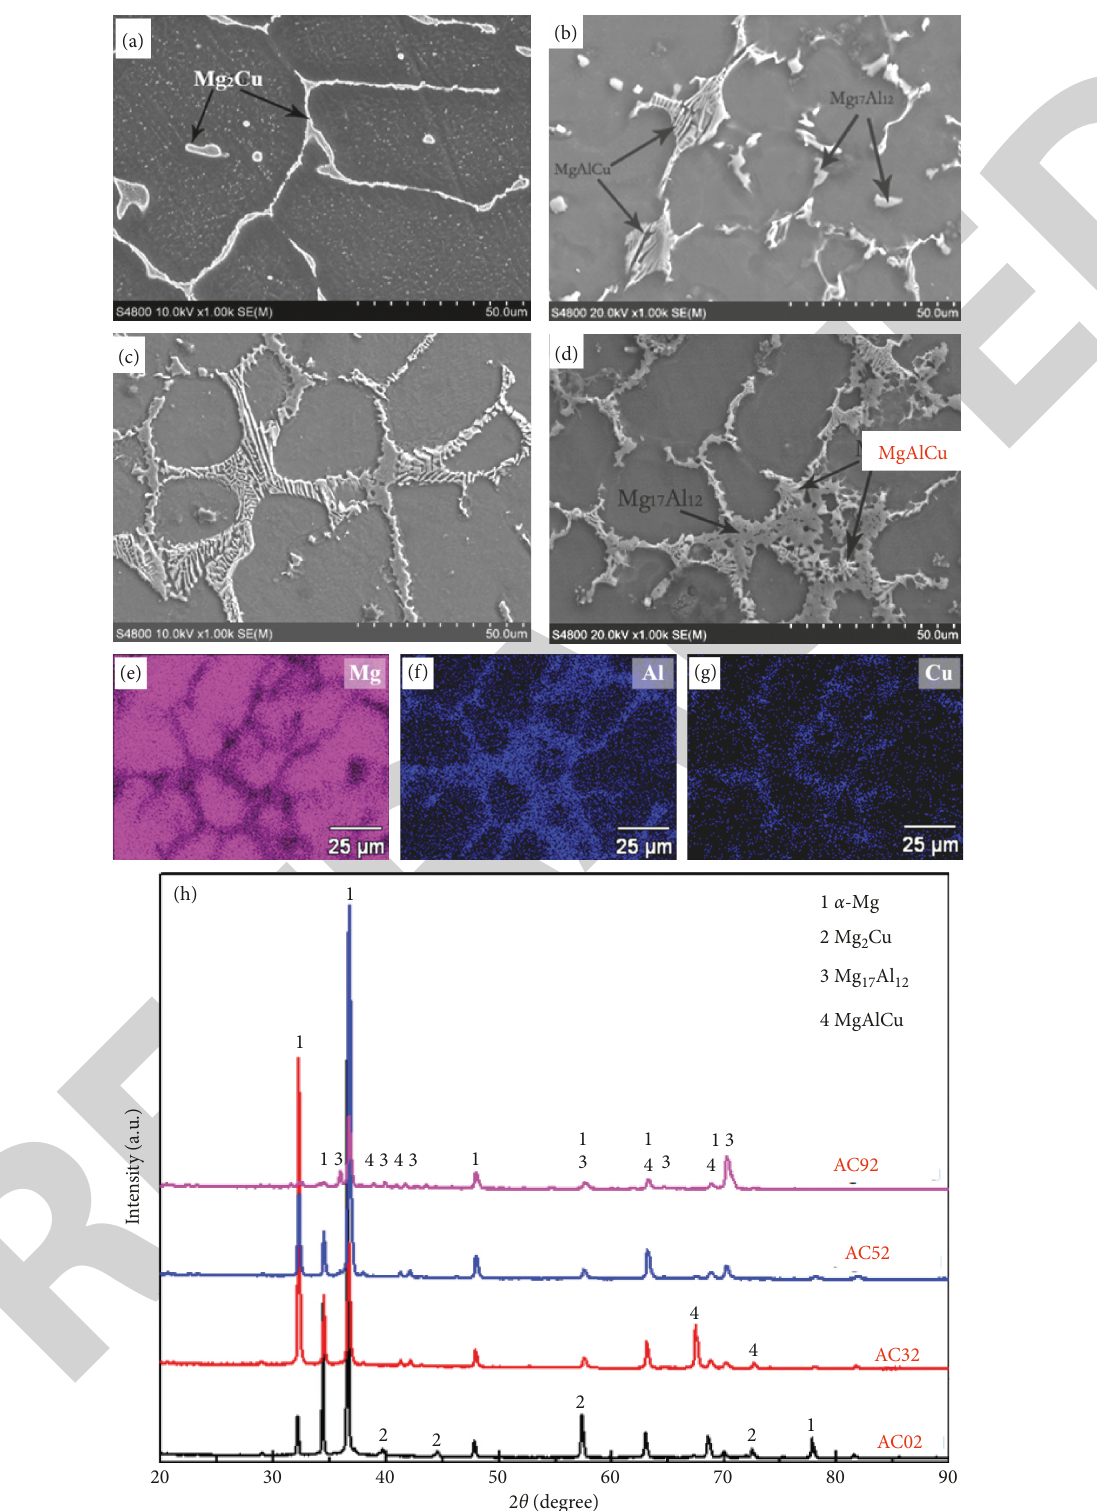
Figure 2: SEM and EDS images and XRD patterns of the ACx2 alloys. (a) AC02, (b) AC32, (c) AC52, (d) AC92, (e) Mg mapping, (f) Al mapping, (g) Cu mapping, and (h) XRD